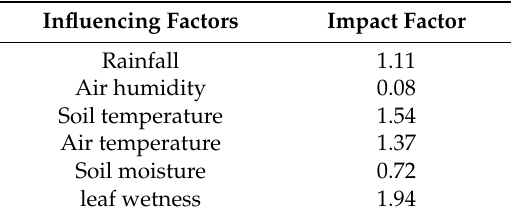
Table 4. Evaluation Results of Affecting Factors on Vegetable Pests in the South.